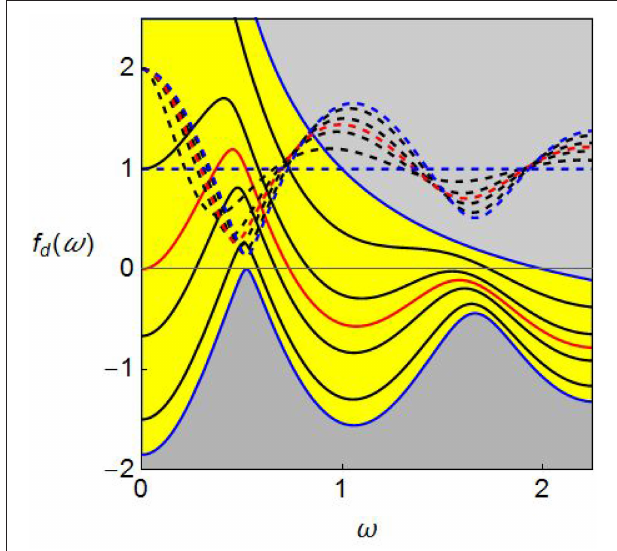
FIGURE 3 | The f d ( ω ) curves with various values of α 1 .